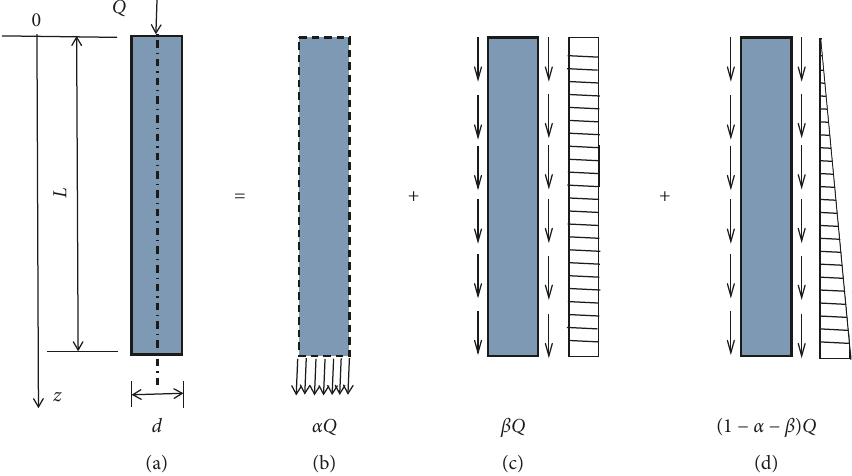
Figure 8: Load-sharing diagram of piles.